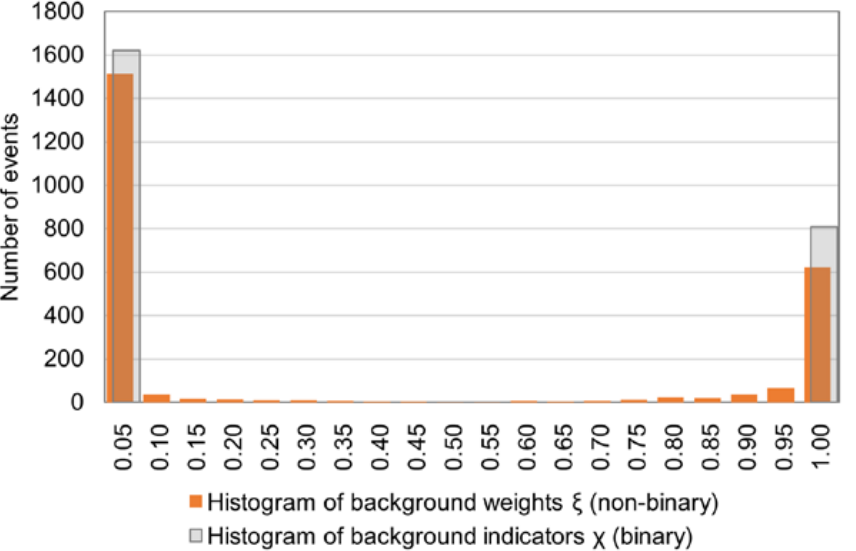
Figure 5. Histogram of background weights ξ i over the epicenter catalogue of the study. A back- ground weight close to 1 indicates a background event while a background weight close to zero indicates a triggered event.